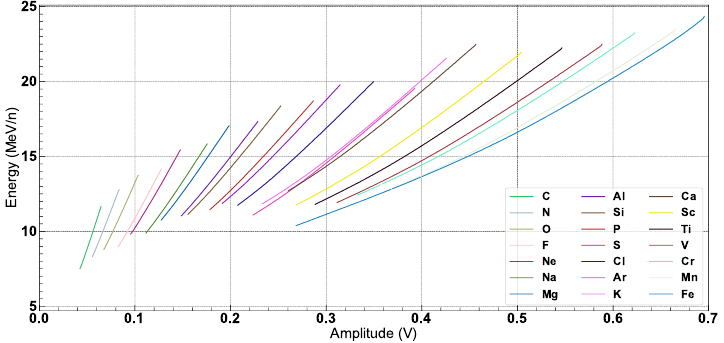
Figure 6. Maximum amplitude vs. 85% Decay time for H-Fe ions stopping in the detector for low gain. The color bar shows the number of events in each bin of this 2D histogram.